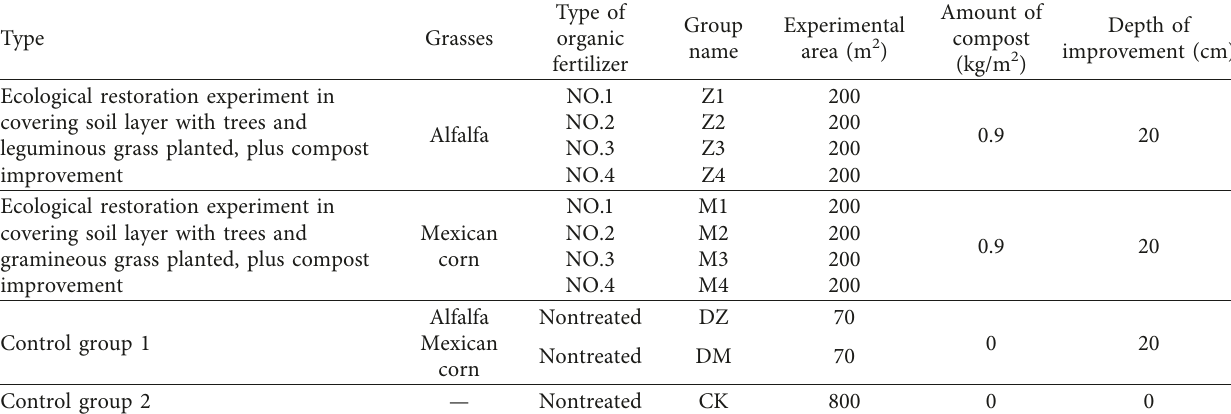
Table 3: Experimental design for compost improvement in the reclamation